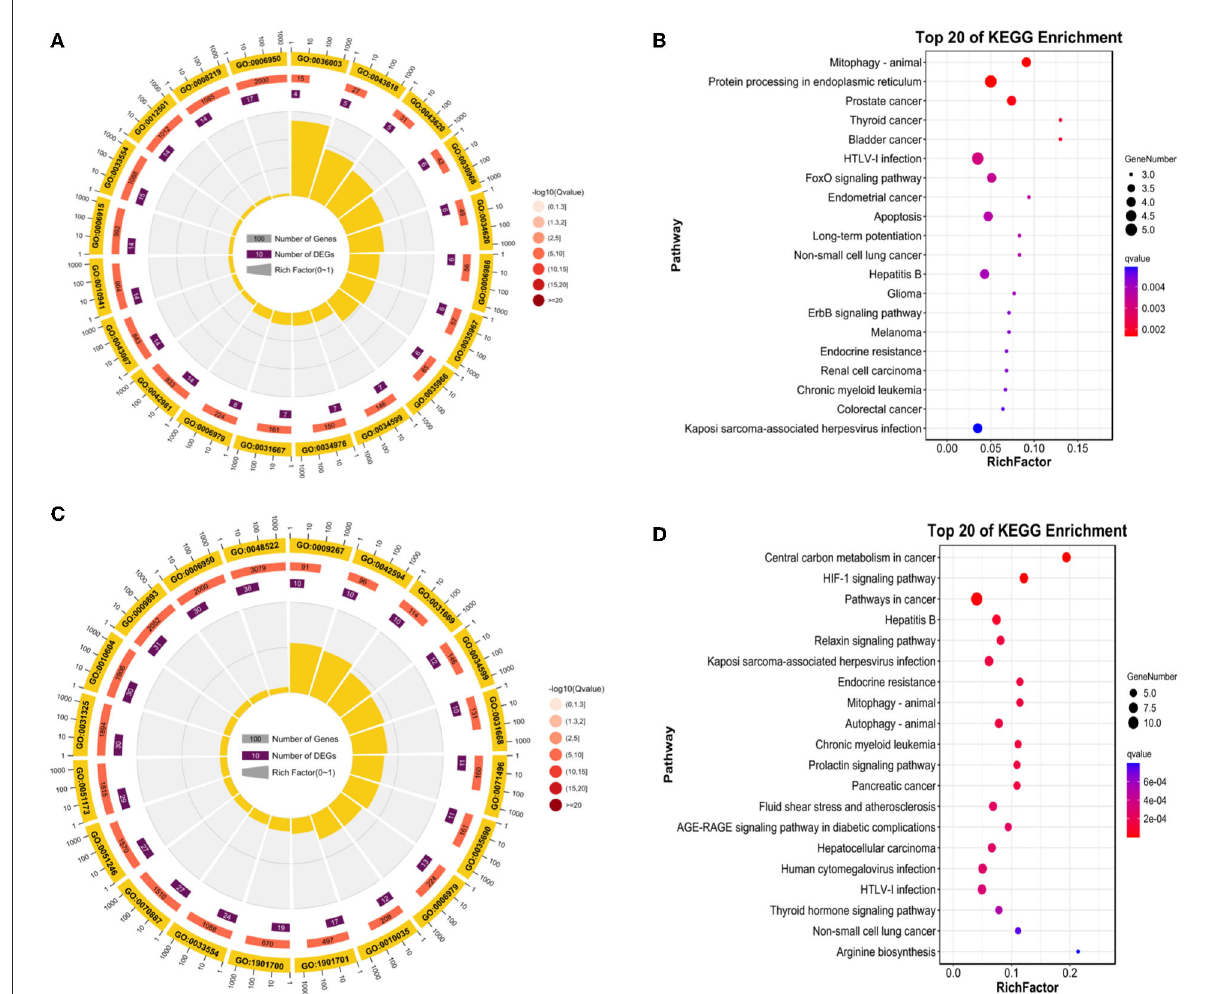
FIGURE5 Enrichment analysis of DE-FRGs. (A) GO enrichment analysis of up-regulated DE-FRGs. (B) KEGG analysis of up-regulated DE-FRGs. (C) GO analysis of down-regulated DE-FRGs. (D) KEGG enrichment analysis of down-regulated